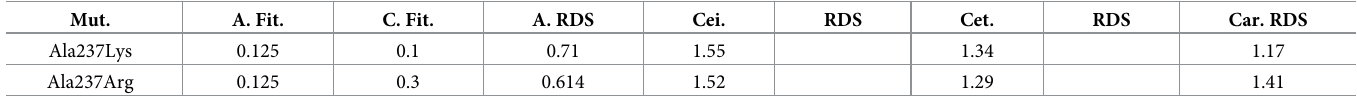
Table 1. Relative docking scores (RDS) and relative fitness values (when applicable) for TEM-Ala237Arg/Lys in complex with ampicillin (A), cefixime (C), ceftibu- ten (Cet), and carumonam (Car).